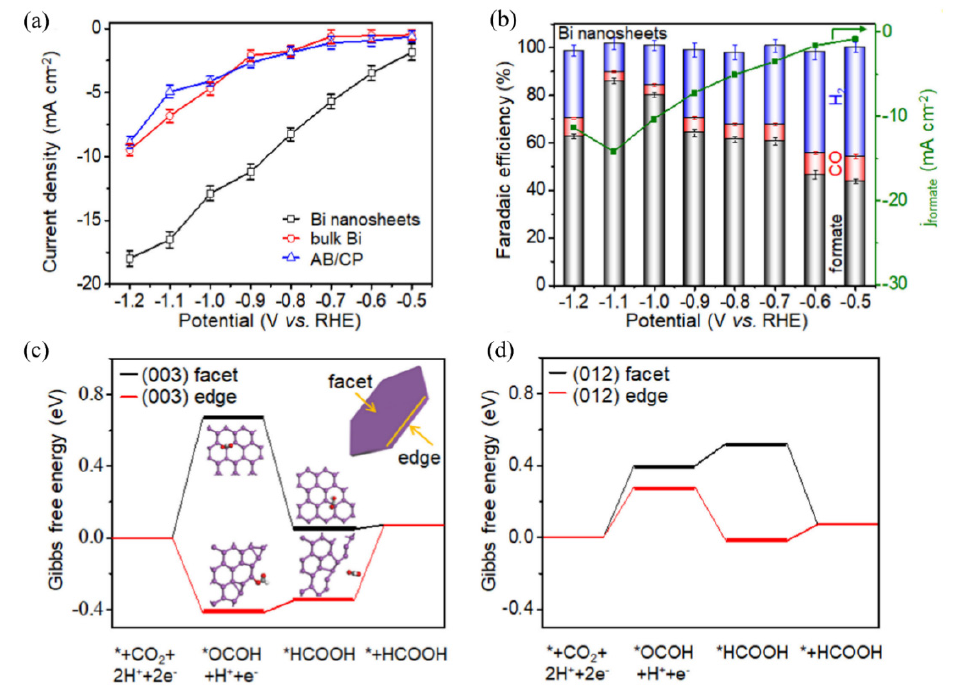
Figure 3. ( a ) Current densities of Bi nanosheets, bulk Bi and acetylene black decorated carbon paper (AB/CP) within a potential window of − 0.5 to − 1.2 V vs. RHE in CO 2 -saturated 0.1 M KHCO 3 aqueous solution. ( b ) Faradaic efficiencies (left Y axes) and partial current densities of formate product (right Y axes) of Bi nanosheets. DFT calculated Δ G in the reaction pathways of CO 2 conversion to formate from the facet sites and edge sites of the ( c ) (003) plane and ( d ) (012) plane on Bi. Reprinted from [76], Copyright (2018), with permission from Elsevier.